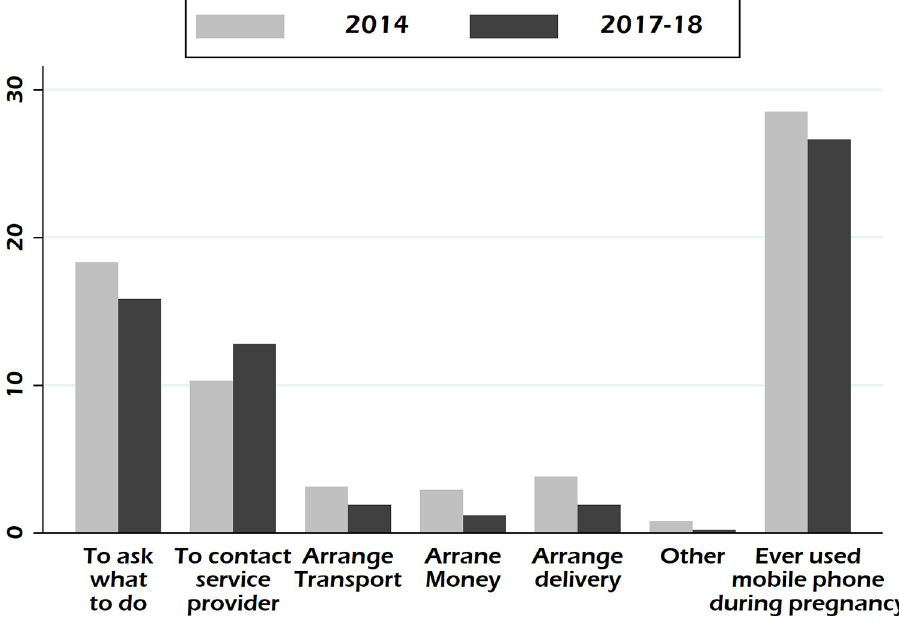
Fig 1. Reasons of using mobile phones for pregnancy-related causes during last pregnancy, Bangladesh Demographic and Health Survey 2014 and 2017–18.